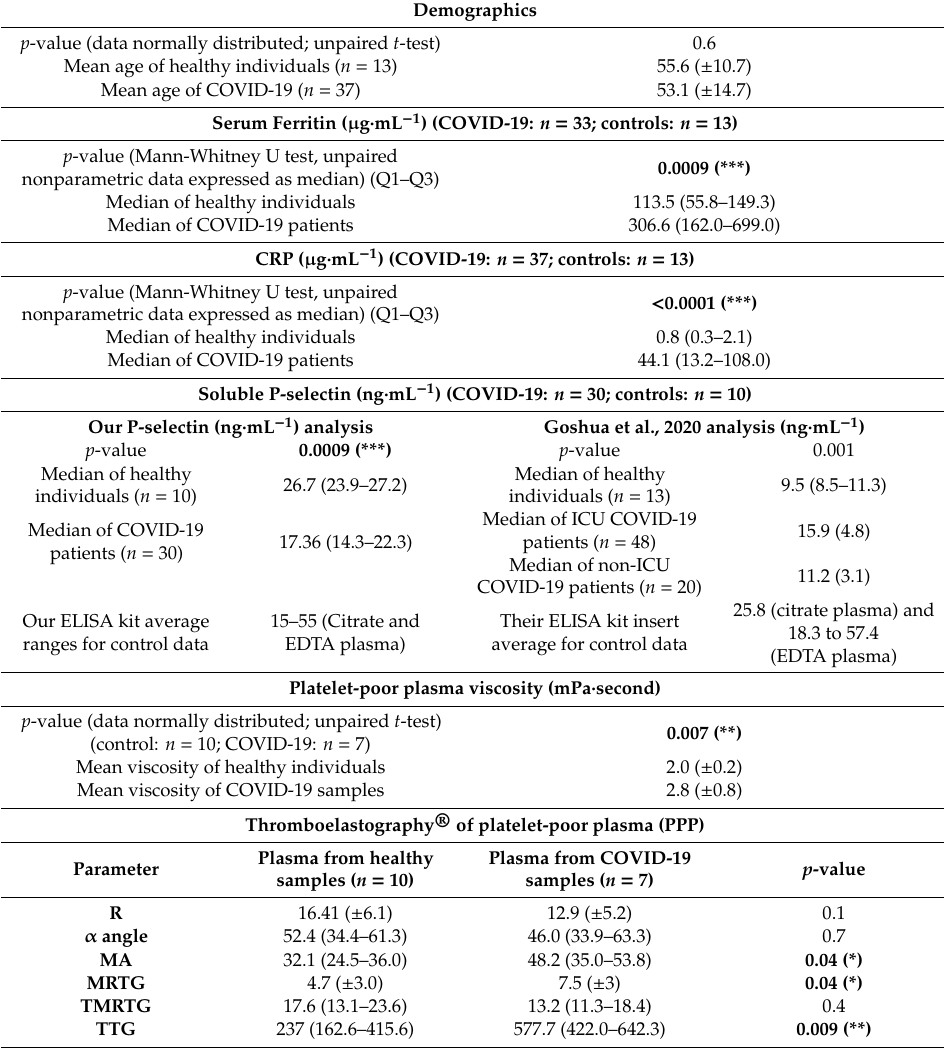
Table 1. Sample demographics and biomarker levels (bold indicates